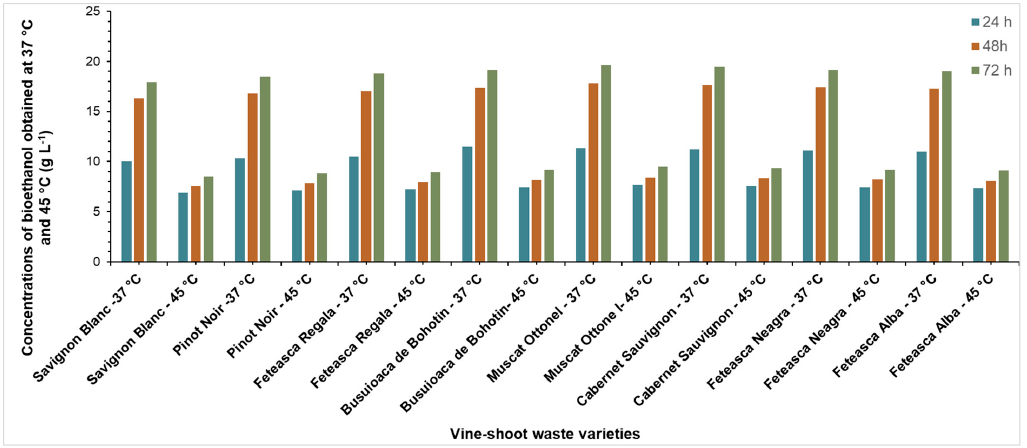
Figure 8. Bioethanol concentration obtained by SSF of vine-shoot waste at 37 °C and 45 °C for pretreatment performed at 165 °C.